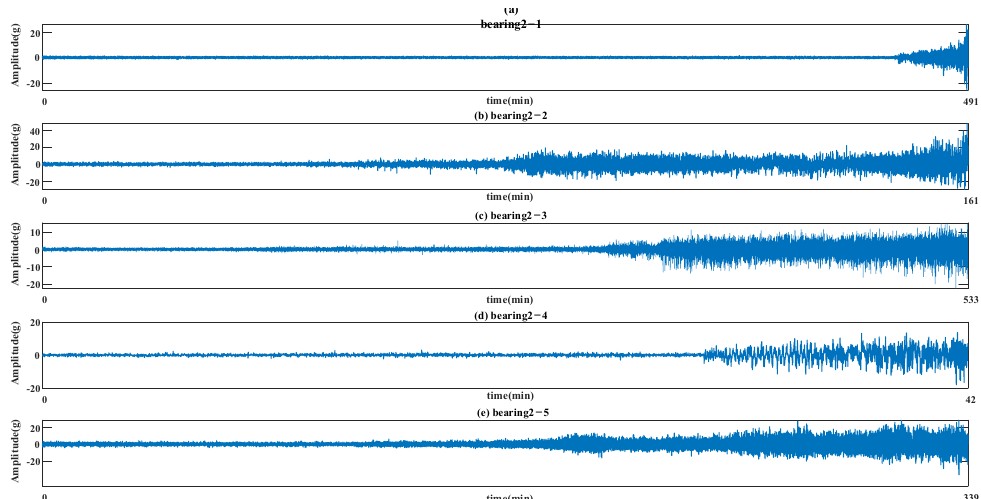
Figure 8. The full cycle data bearing vibration signal.